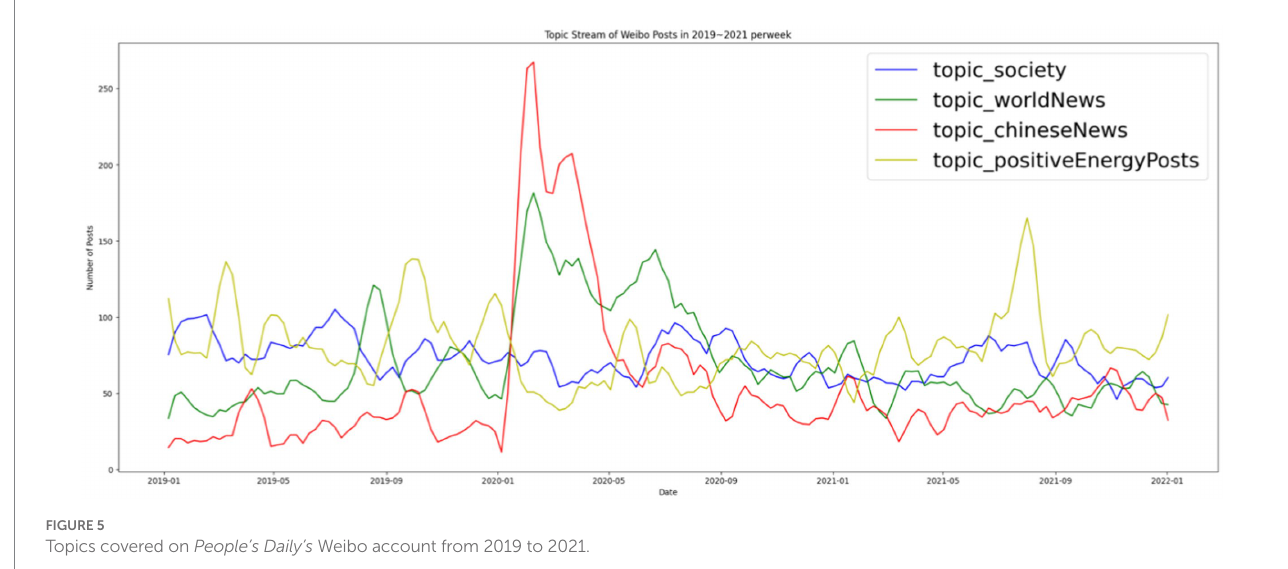
FIGURE 5 Topics covered on People’s Daily’s Weibo account from 2019 to